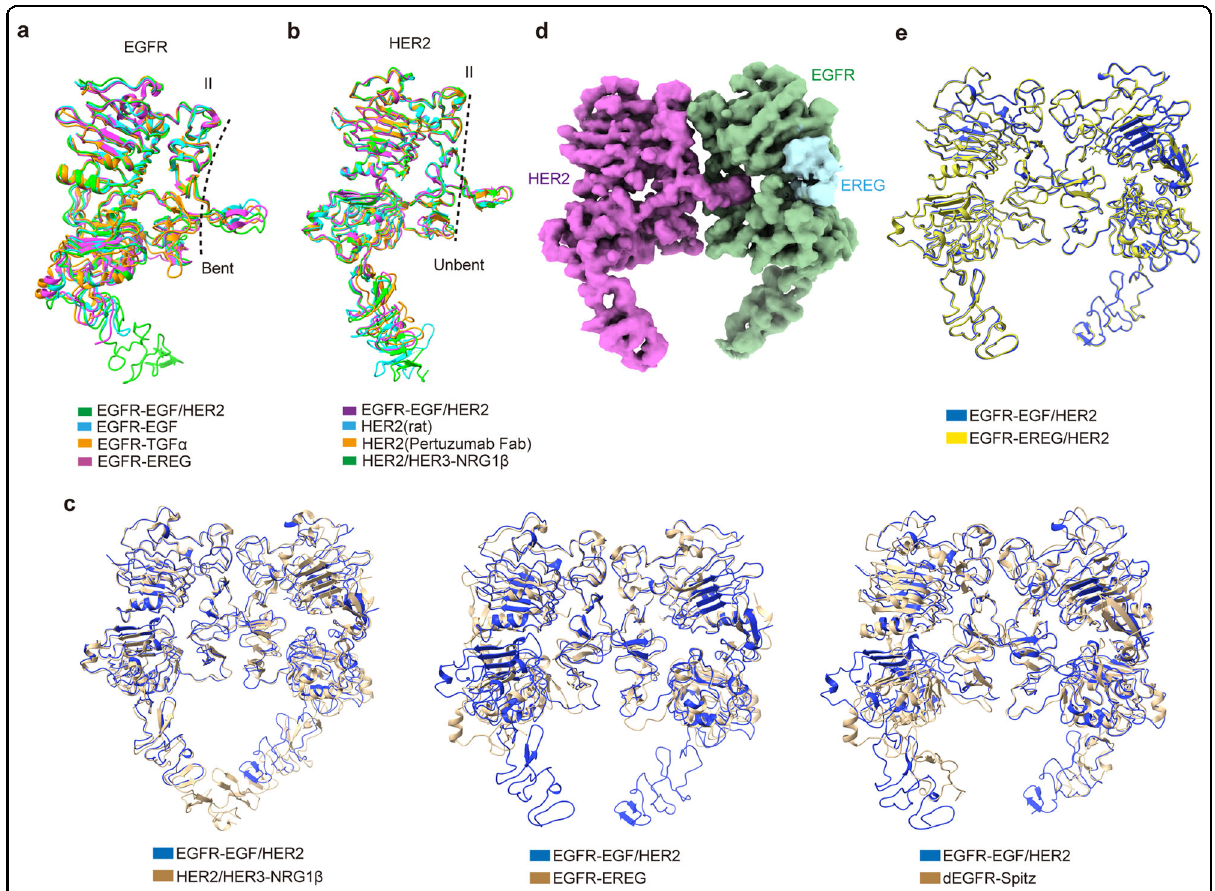
Fig. 2 Structural comparison of different HER family proteins. a Superposition of the individual EGFR subunit structures in different dimers. EGFR in our EGFR/HER2 dimer (green) is superimposed with the bent EGFR protomer structures in EGF (cyan; PDB code: 1IVO)-, TGF α (orange; PDB code: 1MOX)-, and EREG (magenta; PDB code: 5WB7)-bound EGFR dimers. The RMSDs between our EGFR and the other three structures are 1.82 Å, 2.20 Å, and 1.72 Å, respectively. b Superposition of the individual HER2 subunit structures. HER2 in our EGFR/HER2 dimer (magenta) is overlaid with its monomer structure (rat) (cyan; PDB code: 1N8Y), as well as its structure in complex with Pertuzumab Fab (orange; PDB code: 1S78) or HER3 (green; PDB code: 7MN5). The RMSDs between our HER2 and the other three structures are 1.41 Å, 2.15 Å, and 1.34 Å, respectively. c Superposition of our EGFR/HER2 structure (blue) with the currently reported three asymmetric HER dimers (golden), namely, NRG1 β -bound HER2/HER3 (left; PDB code: 7MN5; RMSD 1.95 Å), EREG-bound EGFR (middle; PDB code: 5WB7; RMSD 1.73 Å), and Spitz-bound Drosophila EGFR (dEGFR) (right; PDB code: 3LTG; RMSD 2.68 Å). d Cryo-EM map of the EREG-bound EGFR/HER2 ectodomain complex. EGFR, EREG, and HER2 are colored green, light blue, and magenta, respectively. e Superposition of the EGF (blue)- and EREG (yellow)-bound EGFR/HER2